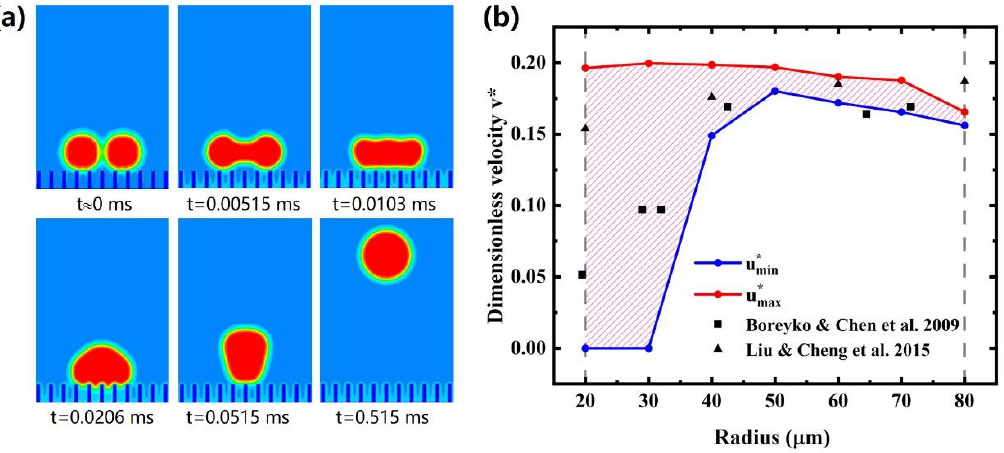
Figure 2. Comparison of simulation results with other studies [1,22]: ( a ) time-lapse images of coalescence-induced droplet jumping; ( b ) dimensionless velocity range of jumping droplets at different radii.